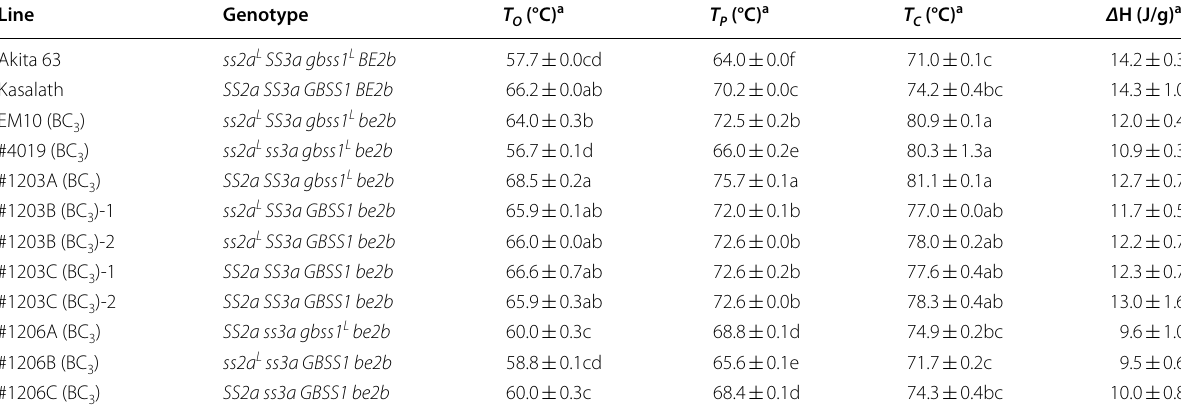
a Data represent mean SE ( n 3). Different lowercase letters indicate significant differences among rice genotypes ( P < 0.05; Tukey–Kramer method). To , onset ± = temperature; Tp , peak temperature; Tc , conclusion temperature; ΔH , gelatinization enthalpy of starch